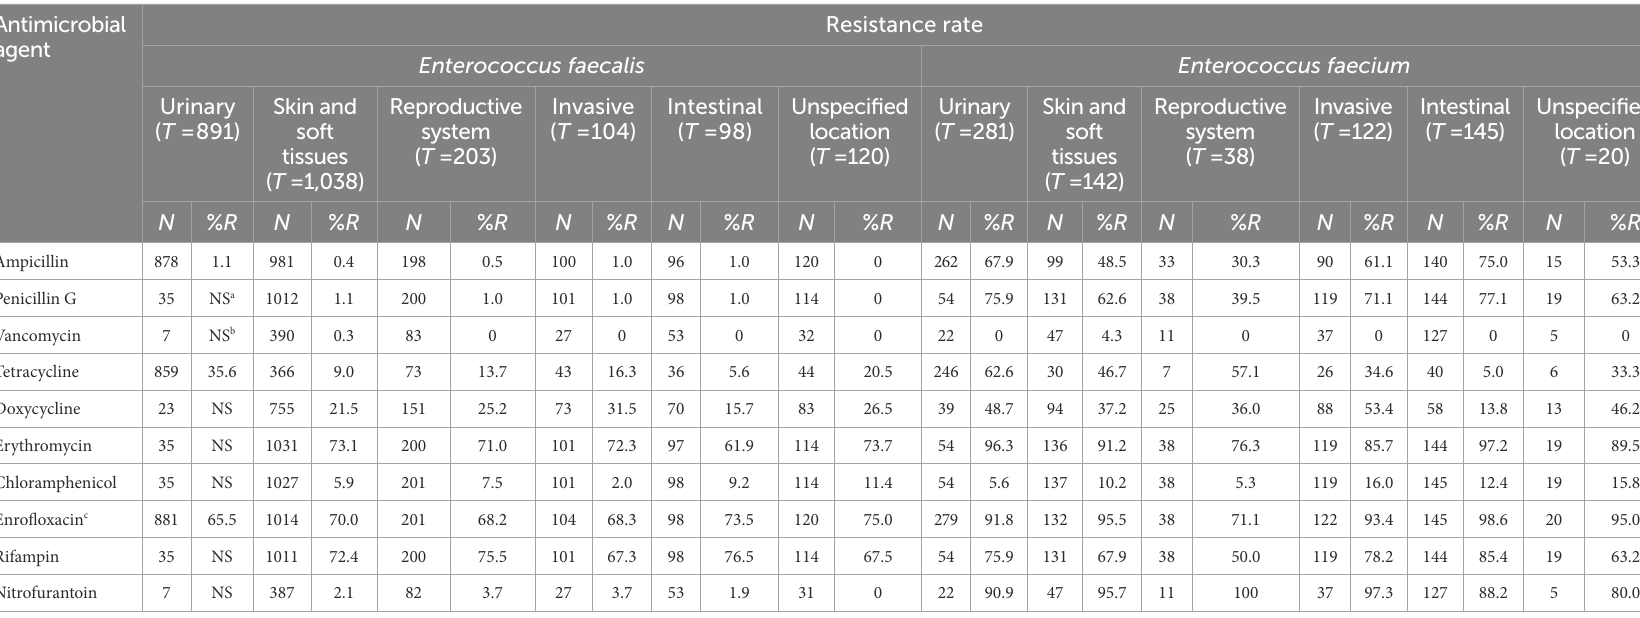
TABLE 2 Prevalence of antimicrobial resistance among Enterococcus spp. clinical isolates from dogs stratified by sample source, from canine clinical infections at the Cornell University Animal Health Diagnostic Center (AHDC), 2007–2020. Antimicrobial agent